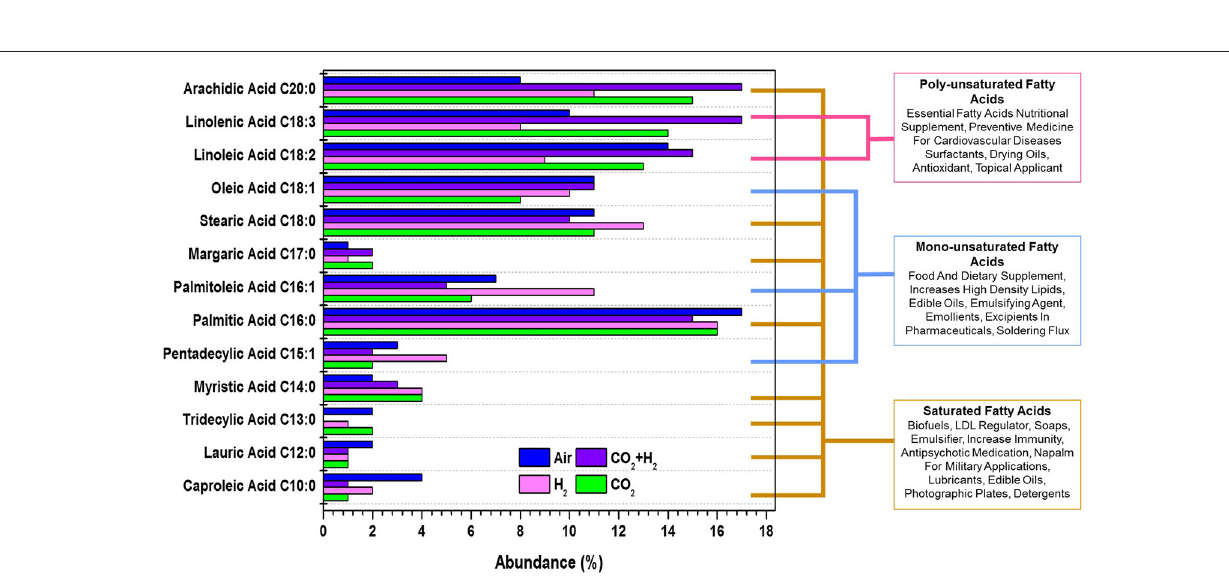
Frontiers in Energy Research |